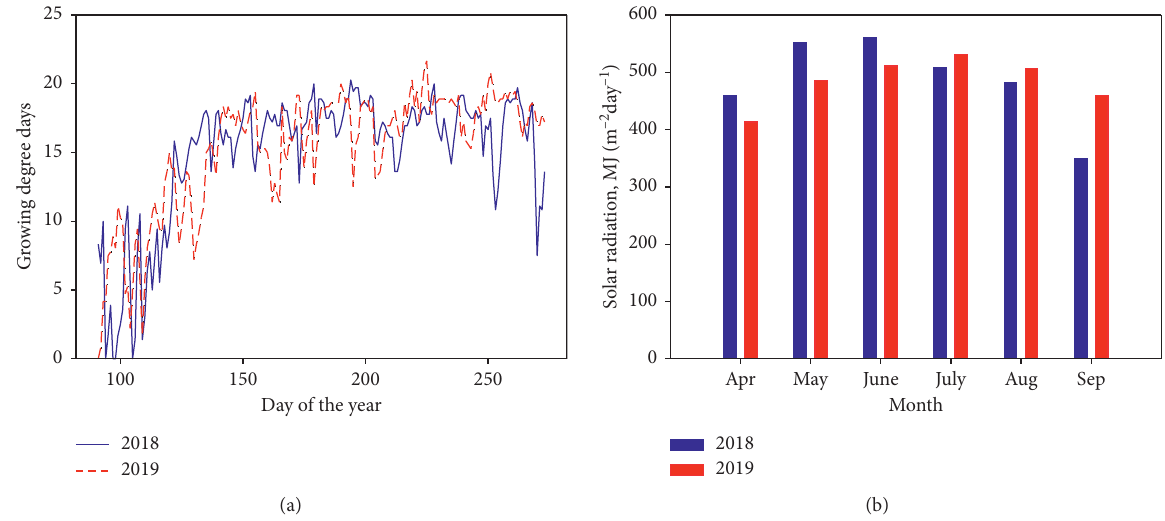
Figure 2: Measured (a) growing degree days (GDD) and (b) solar radiation in 2018 and 2019 soybean growing seasons at Stoneville, MS, USA.